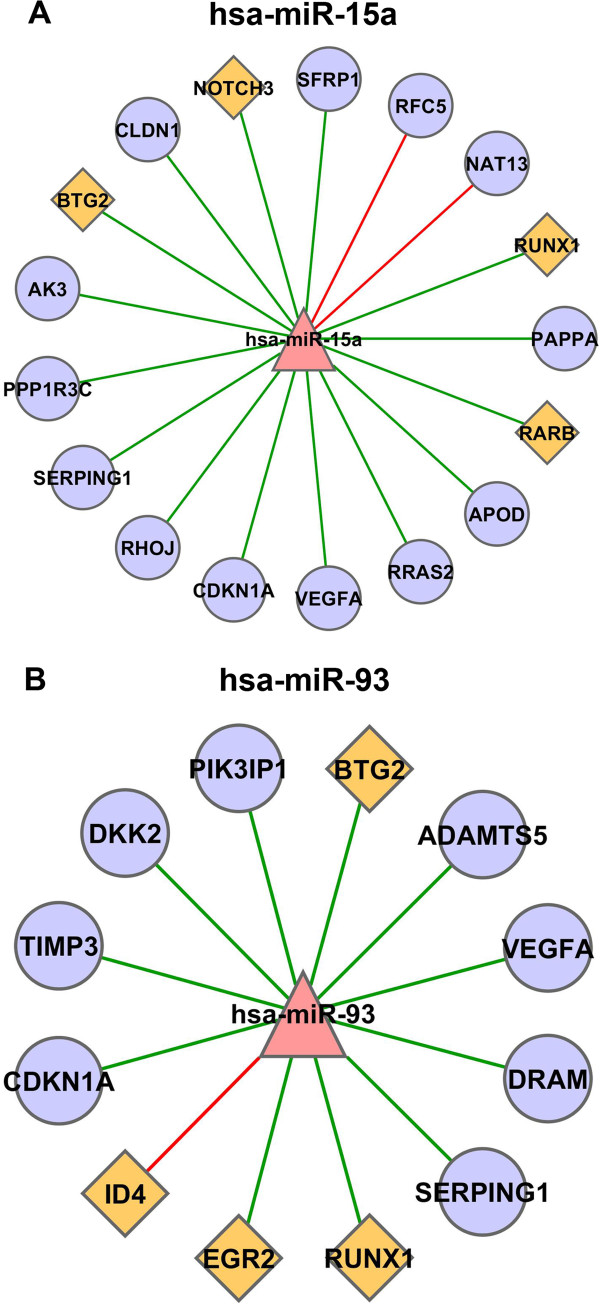
Correlation networks of miR-93/miR-15 and their high confidence target genes. We used 10 prediction tools to obtain, based on public data, candidate miRNA-mRNA target interactions and we identified high confidence targets by mRNA and miRNA expression. We calculated Pearson correlation coefficients between miRNAs and their targets. Results of the analysis are presented here for miR-93 (A), and miR-15 (B). The color and shape of nodes are based on different node attributes available for the analyzed dataset. The red triangles, purple circles and orange diamonds in the network are indicating miRNAs, target genes, and transcription factors, respectively. Edges represent correlation between miRNAs and mRNAs, the color of the edges designate the type of interaction. Red is for positive and green is for negative correlation.